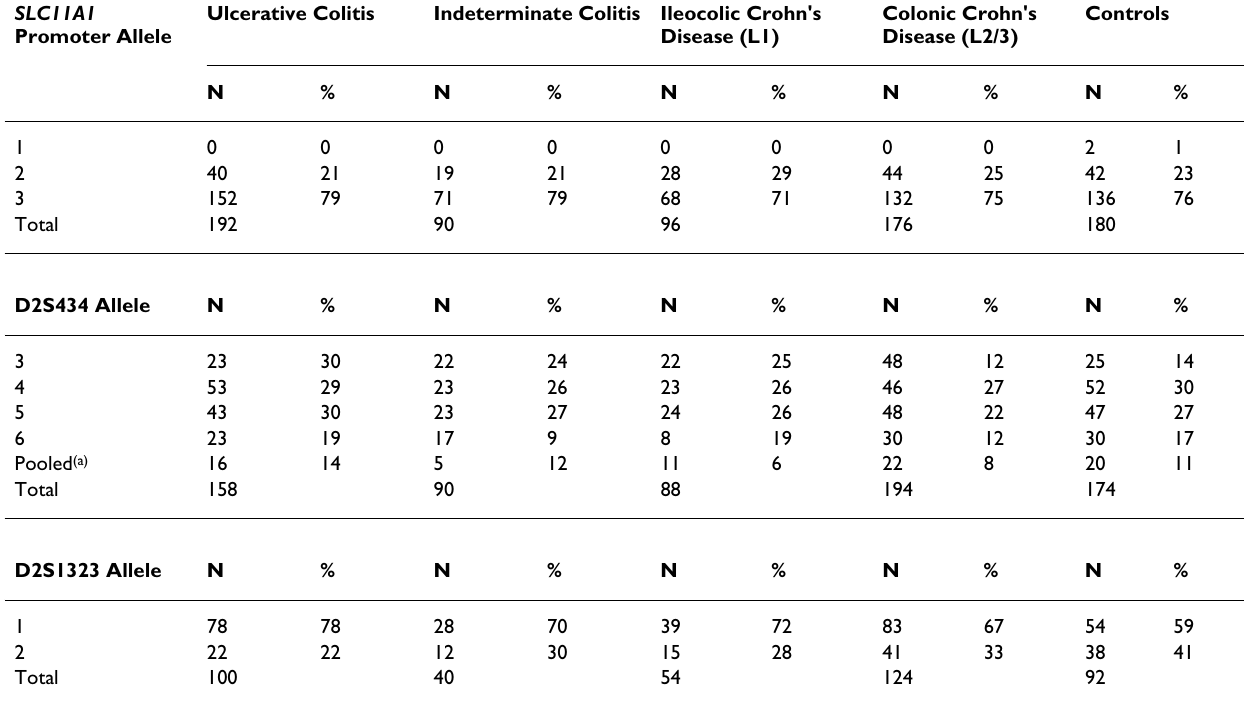
Table 2: Polymorphism allele frequencies.